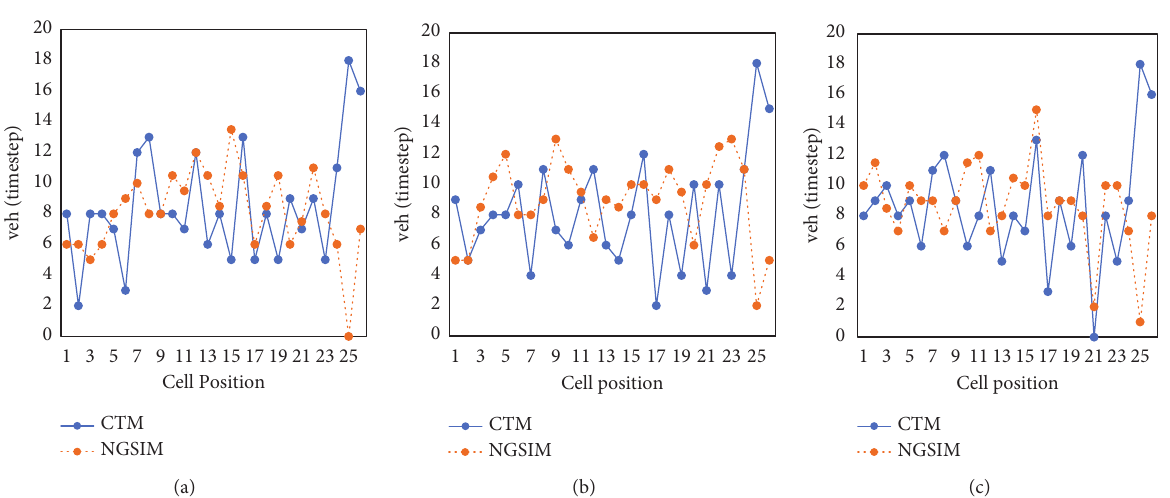
Figure 11: Comparison of the occupancies between CTM and I80 at the (a) 50 th , (b) 75 th , and (c) 100 th -time